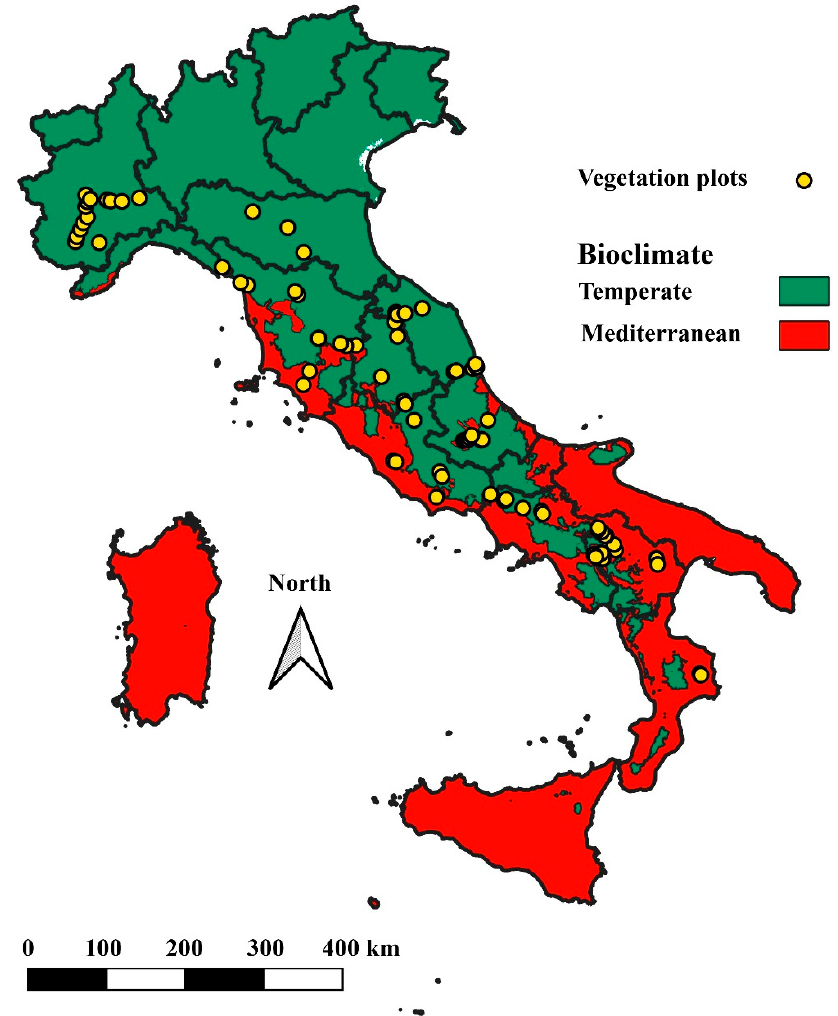
Figure 1. Location of the vegetation plots in Italy and main bioclimatic types (modified from [39]).